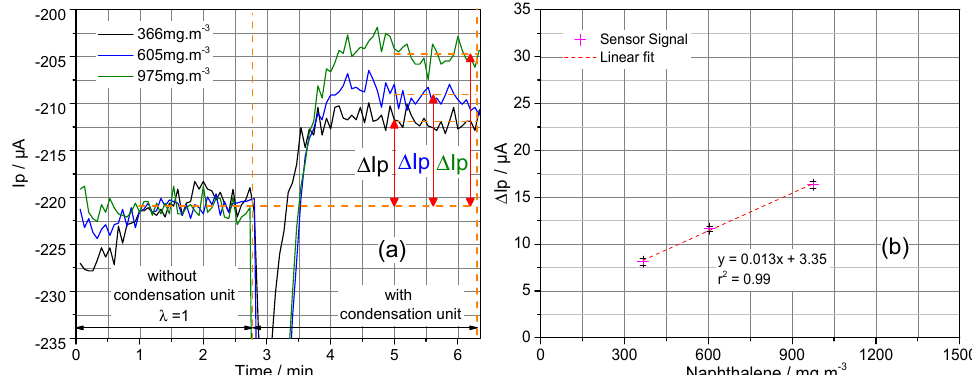
Figure 7. Δ Ip at a constant stream of model syngas (N 2 /CH 4 /naphthalene), as extracted by a filter/Laval nozzle/gas pump-setting (Figure 3). ( a ) Signals of an LSU 4.9 oxygen sensor at setting 1 (without condensation) and setting 2 (with condensation) vs. the time of one period of measurement. ( b ) Δ Ip vs. the concentration of naphthalene.